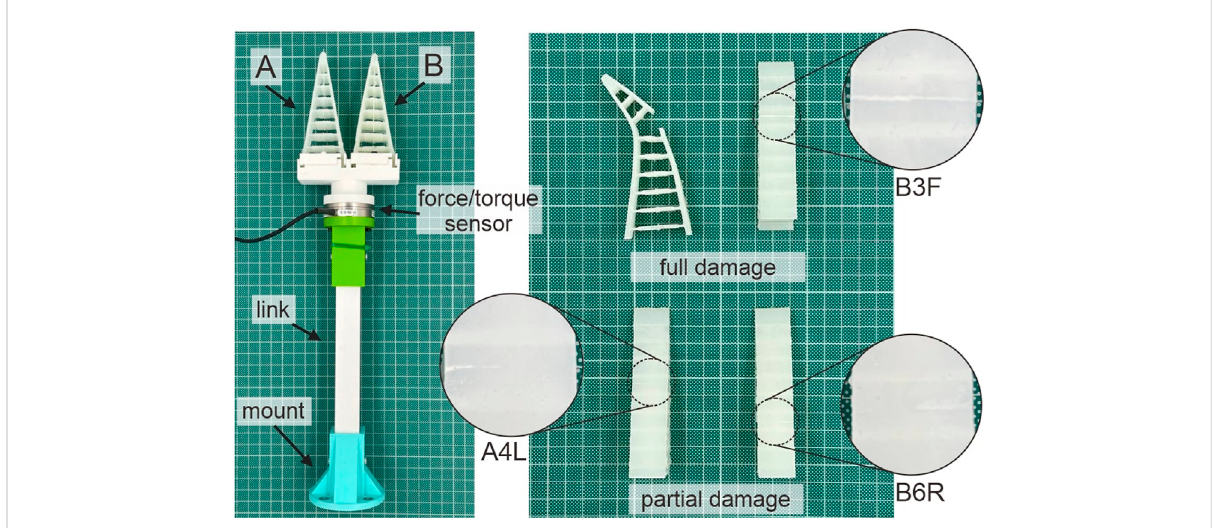
FIGURE 5 Two- fi ngered Fin Ray gripper and examples of possible damage. On the left, the gripper equipped with a force/torque sensor at the mounting pointofsoft fi ngersisillustrated.Examplesofpartialandfulldamagearepresentedtotheright.Partialdamagestartingfrombothedgesisconsidered in this study